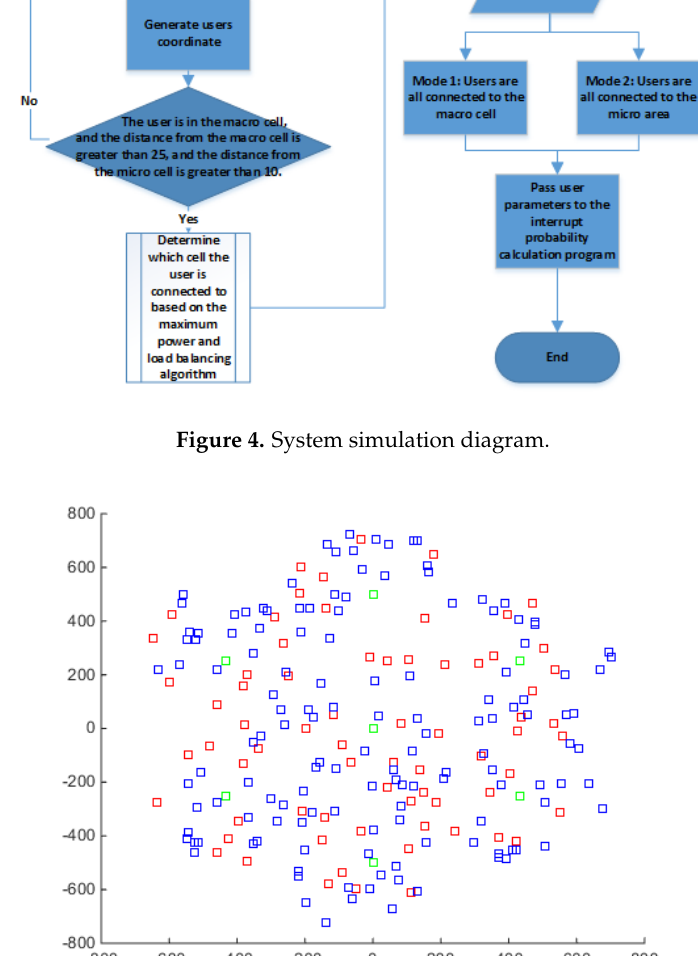
Figure 5. Hierarchical heterogeneous network model (7 macro cells, 70 micro cells, 140